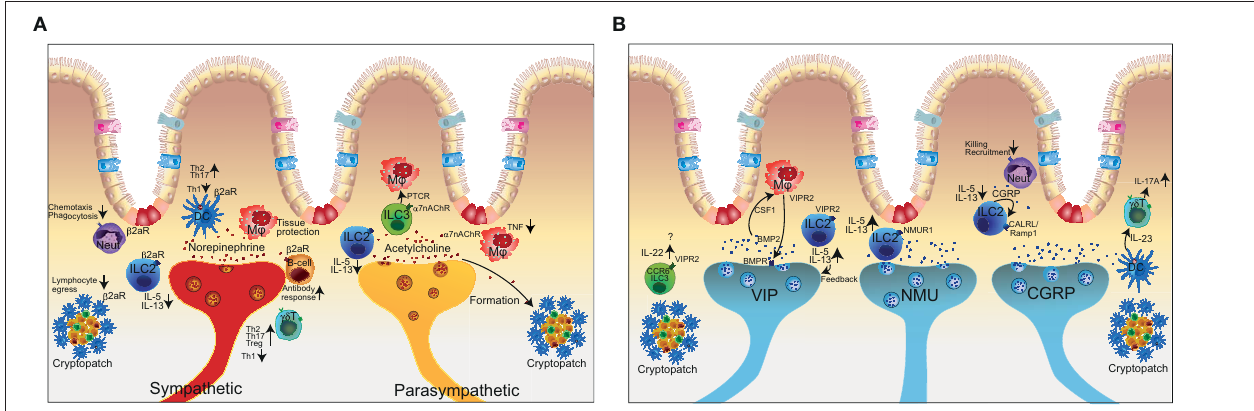
FIGURE 3 | The complex interactions of the enteric nervous system with innate and adaptive immune cells. (A) Representation of the close co-localization of extrinsic neuronal fibers and immune cells in the intestine. Sympathetic signal transmission (red axon) using (nor-)epinephrine can exert pro- and anti-inflammatory effects depending on the immune cell and respective receptor activation. The sympathetic nervous system in addition controls lymphocyte egress from lymph nodes. The parasympathetic nervous system (yellow axon) in general has anti-inflammatory effects but is also involved in the formation of tertiary lymphoid organs. (B) Schematic representation of intrinsic neuronal subsets of the enteric nervous system (VIP, NMU, CGRP) and the interaction with immune cells. Neut, neutrophil granulocyte; DC, dendritic cell; M φ , macrophage; ILC, innate lymphoid cell; γδ T, gamma-delta T cell; α 7nAChR, alpha7 nicotinic acetylcholine receptor; β 2aR, beta2 adrenergic receptor; VIP, vasoactive intestinal peptide; NMU, neuromedin U; CGRP, calcitonin-gene related peptide; VIPR2, vasoactive intestinal peptide receptor 2; NMUR1, Neuronmedin U receptor 1.